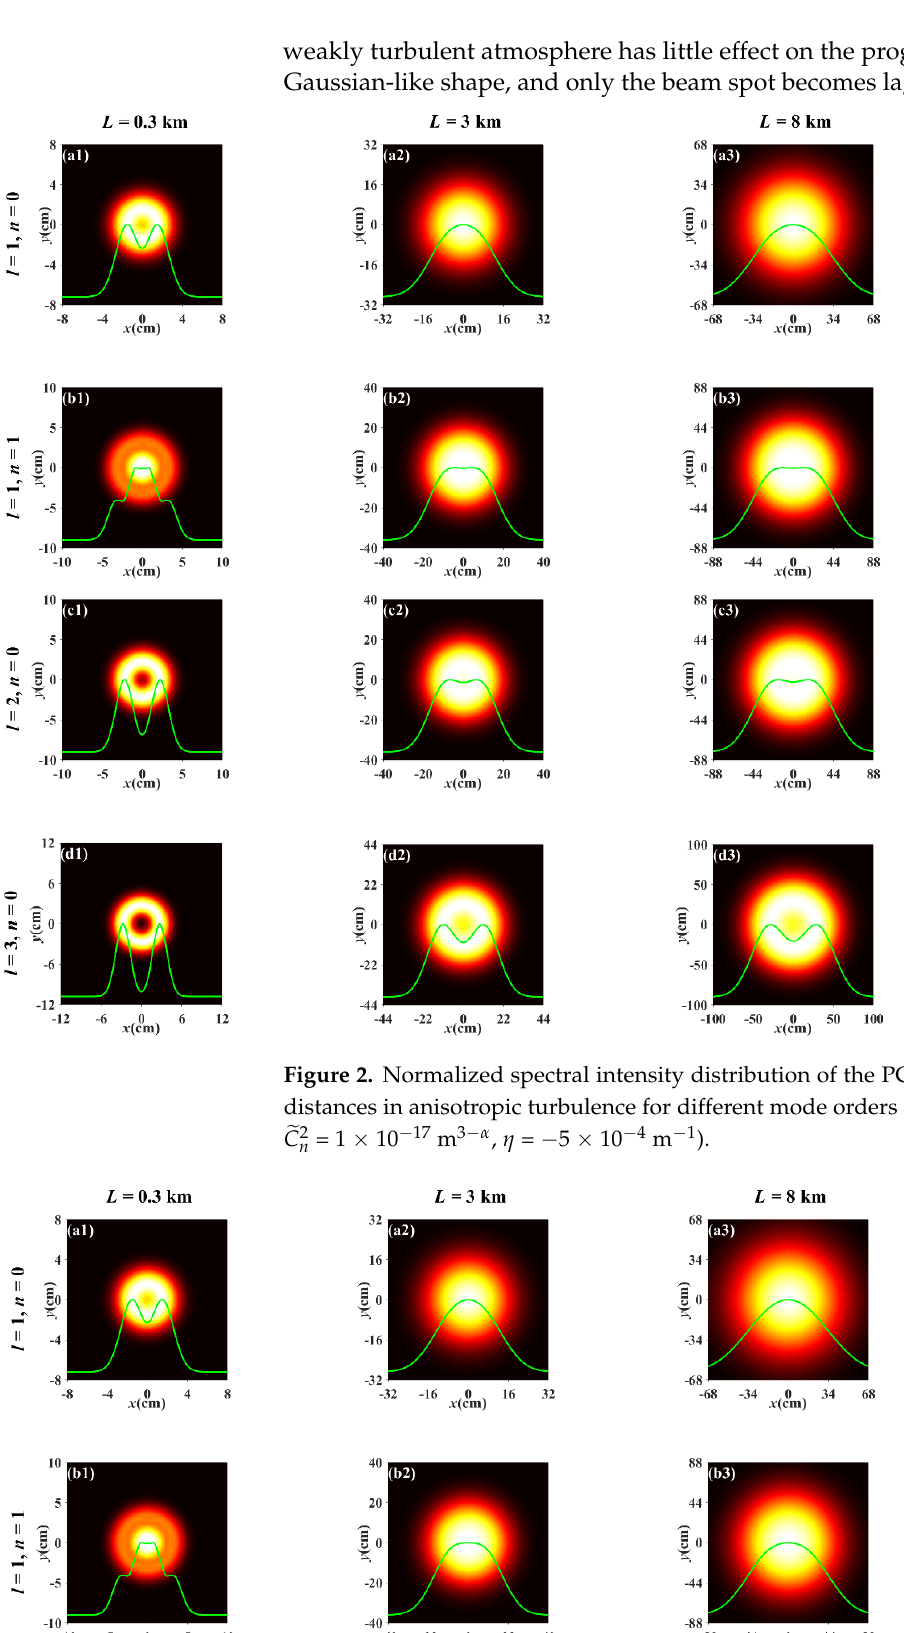
7 of 14 Figure 1. Normalized spectral intensity distribution of ( a1 – a8 ) the PCLGP beam and ( b1 – b8 ) the PCTLGP beam at several propagation distances in anisotropic turbulence ( ξ x = ξ y = 3, l = 1, n = 1, C ̃ ͂ 2 n = 1 × 10 − 14 m 3 − α ). Next, we focus on the influence of the topological charge on the evolution proper- ties during propagation. Figure 2 shows the normalized spectral intensity distribution of the PCTLGP beam propagating through the anisotropic non-Kolmogorov turbulence (C ̃ 2 n = 1 × 10 − 17 m 3 − α ) at several propagation distances for the different topological charges. Figure 2a,c and d presents that the normalized spectral intensity distribution of the PCTLGP beam gradually evolves from a dark hollow distribution to a flat-topped distri- bution when n = 0, and finally converges into a Gaussian-like distribution. Figure 2b displays the normalized spectral intensity distribution of the PCTLGP beam when n ≠ 0, and the results shown agree with those discussed in Figure 1. Importantly, we find that